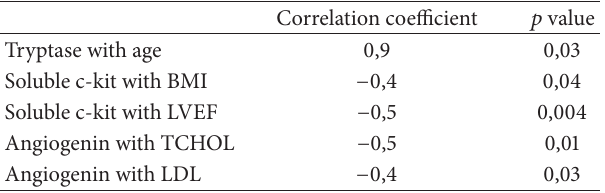
Table 4: The linear regression model of correlation between demo- graphicandbiochemicaldatain33STEMIpatients.Theanalysiswas made using linear regression model.